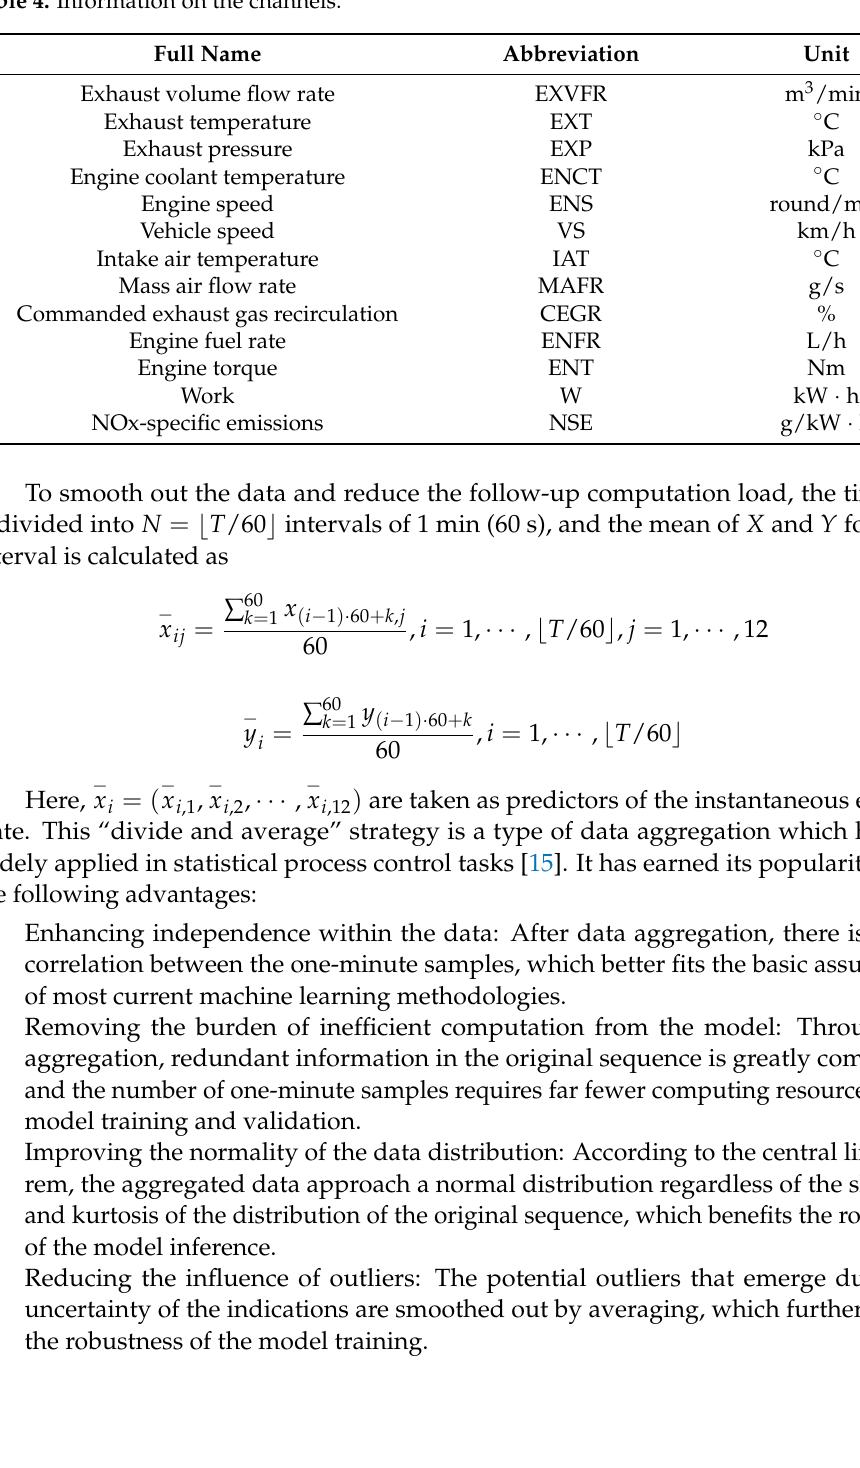
Table 4. Information on the